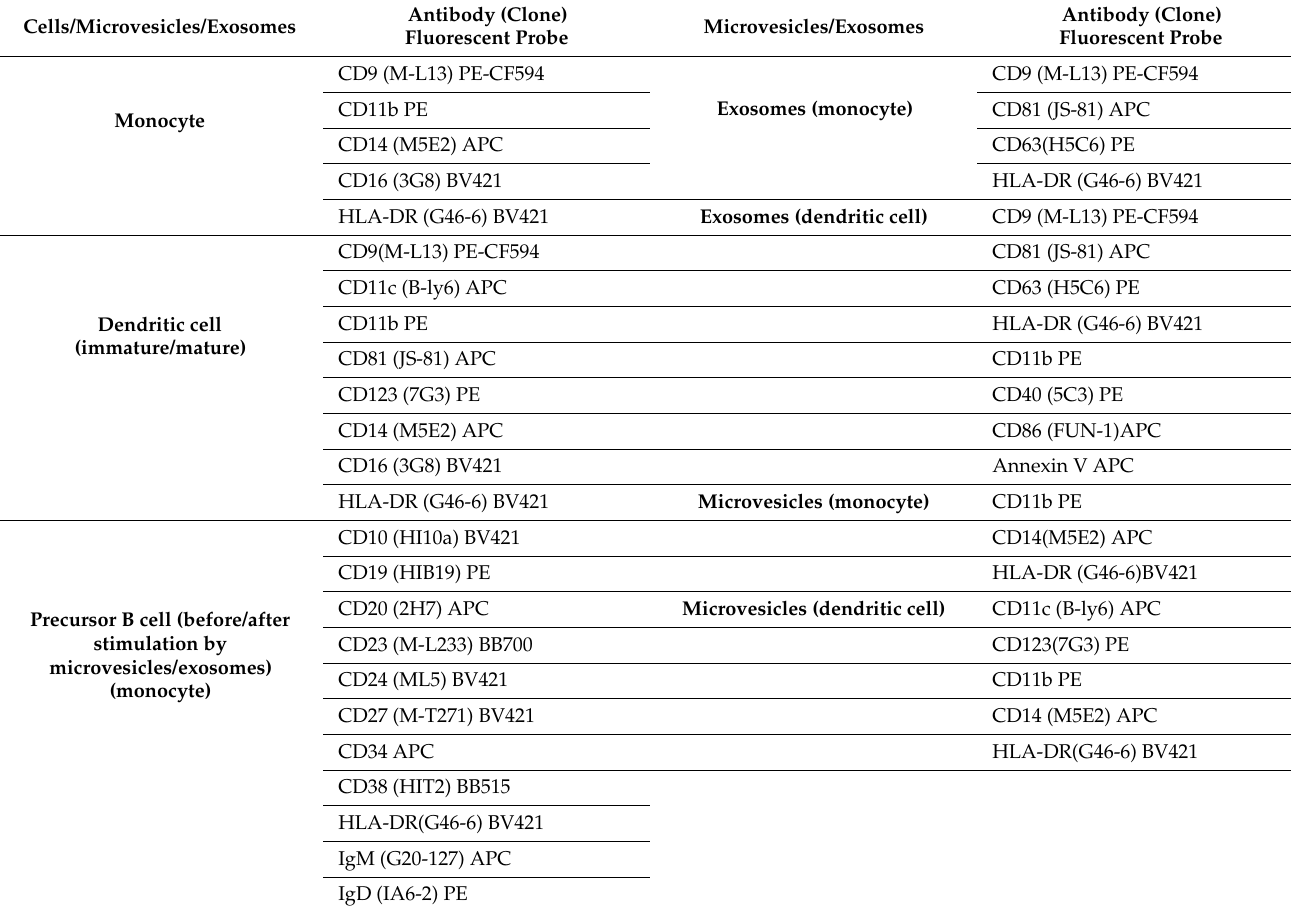
Table 1. Monoclonal antibodies used in the